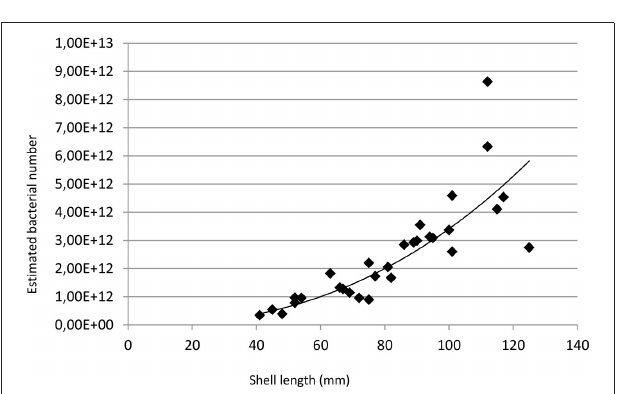
FIGURE 6 | Total estimated bacterial numbers (n SYMB ) vs. shell length (SL) in mm. The line represents to the best fitting power function ( R 2 = 0.84) and follows the equation n SYMB = 6.10 7 * SL 2.39